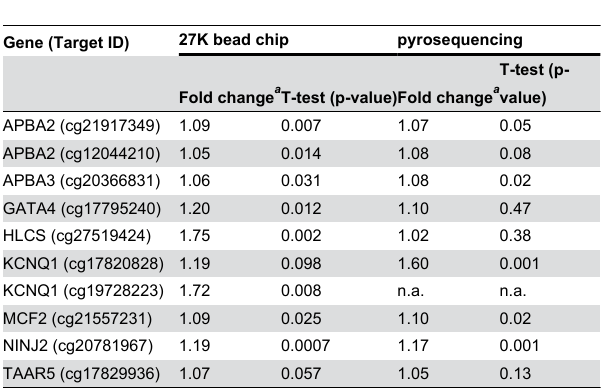
Table 2. Differentially methylated CpGs by 27K bead chip and